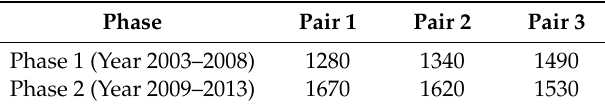
Figure 13. Distribution of lean zones: ( a ) 3D view; ( b ) 2D view. Table 2. Average injection pressure (kPa).